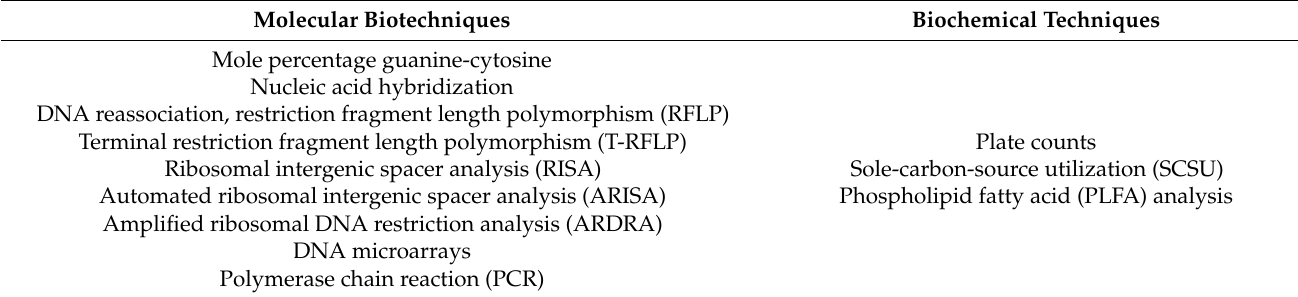
Table 2. Some of the biochemical and molecular methods for determination of microbial diversity [47]. Different platforms and sequencing technologies have been listed in detail by Kulski 2015 [52]. Molecular Biotechniques Biochemical Techniques Mole percentage